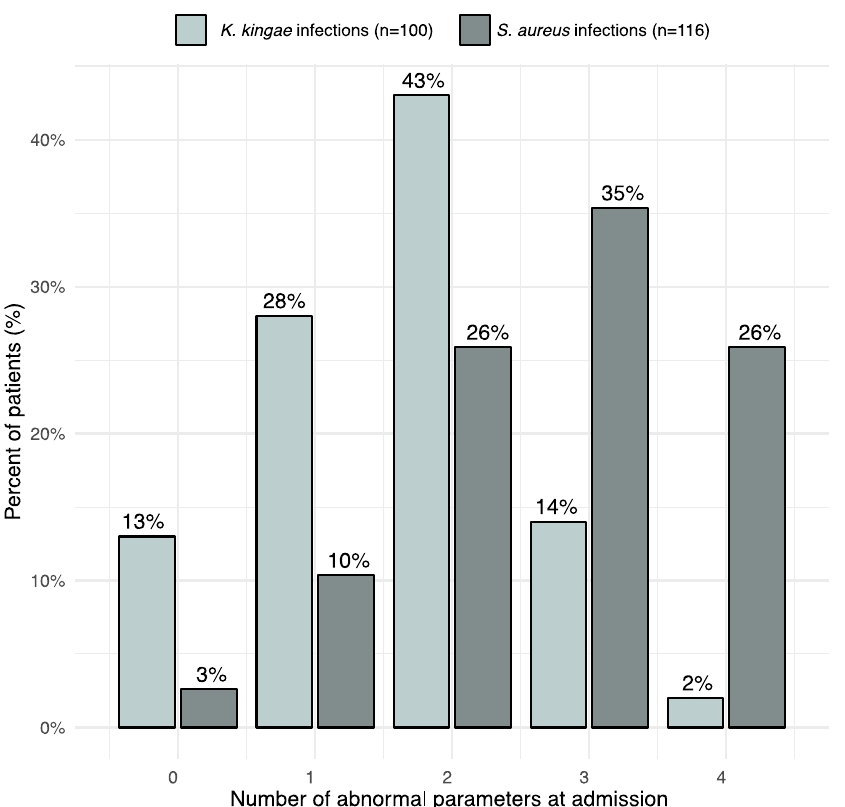
Figure 4. Number of abnormal values present at admission in per cent for the four usual infection predictors (temperature ≥ 38 °C; WBC ≥ 17,000/mm 3 for children less than 4 years old and ≥ 12,000/mm for those ≥ 4 years old; ESR ≥ 20 mm/h; and CRP ≥ 10 mg/L). We observed that most K. Kingae OAIs had two or fewer parameters above the normal levels at admission.